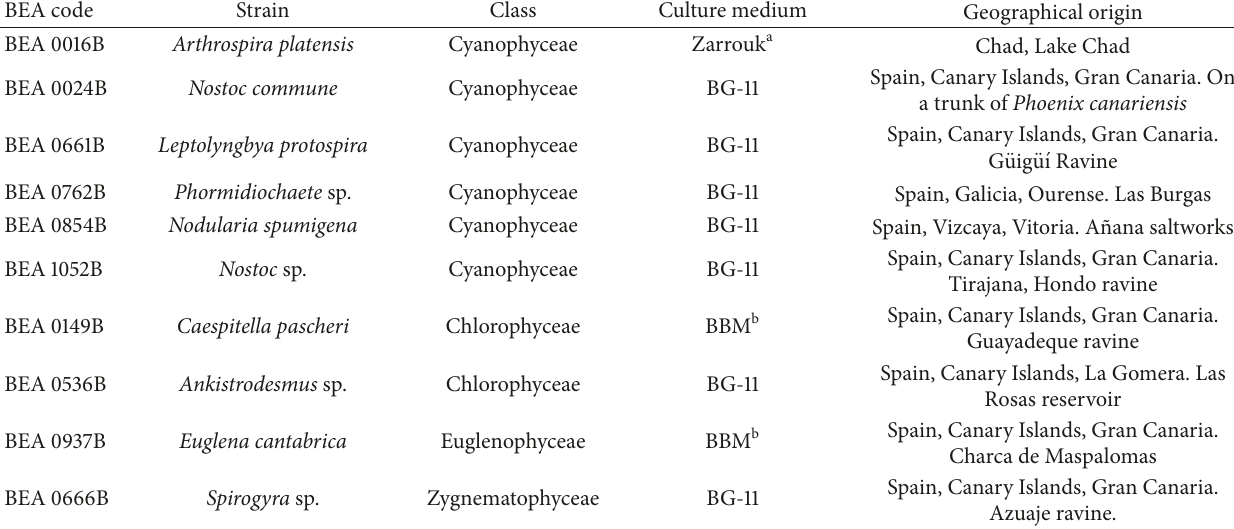
Table 1: Microalgae and cyanobacteria strains assayed, indicating origin and culture medium for biomass